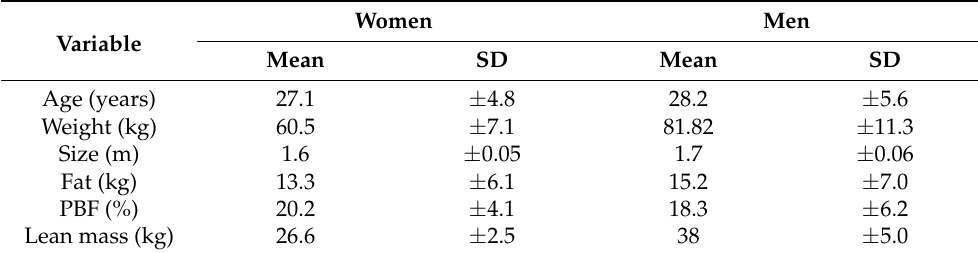
Table 1. Characteristics of CrossFit